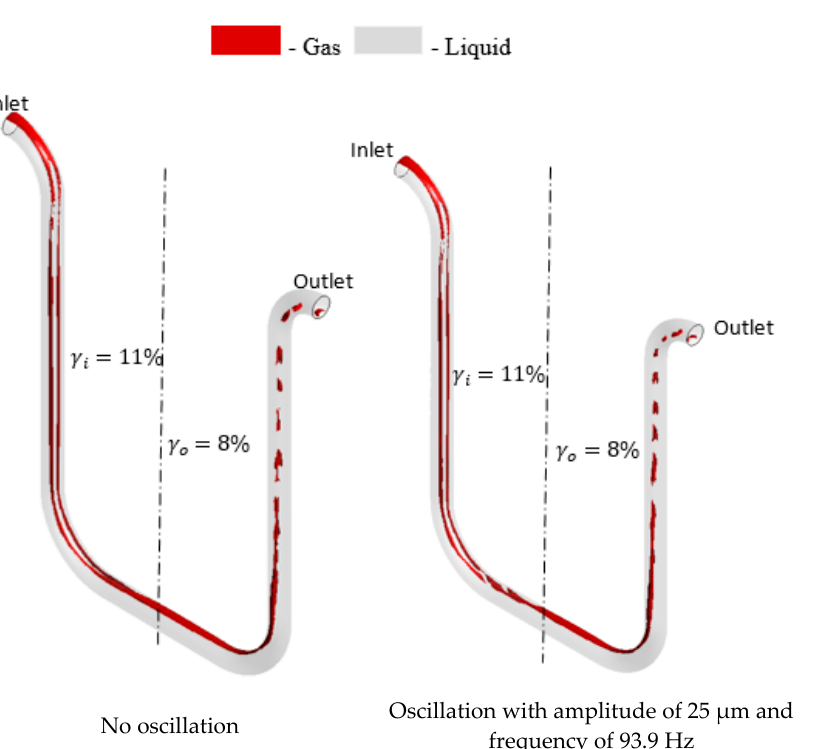
Oscillation with amplitude of 25 μ m and No oscillation frequency of 93.9 Hz Figure 10. The gas distribution in flowmeter tube with and without oscillation at 149 kg/min mixture flow rate, 9% GVF at the inlet, CMF200.